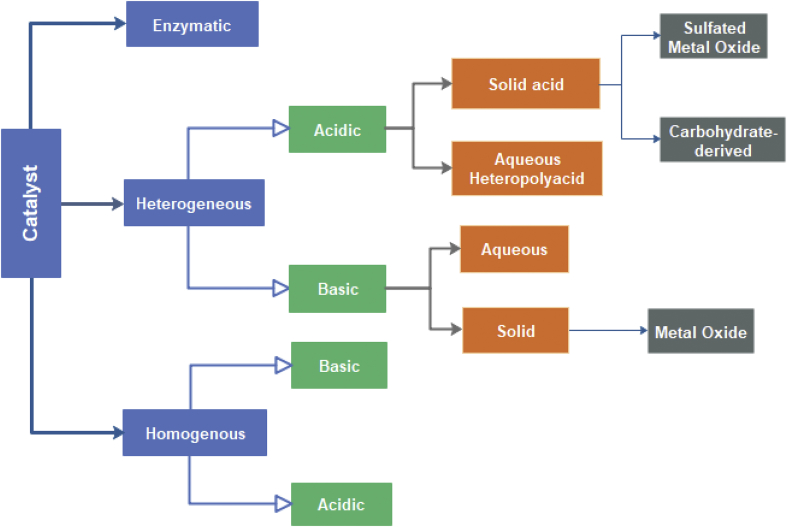
Overview of conventional catalyst types (Lokman et al. 2015).